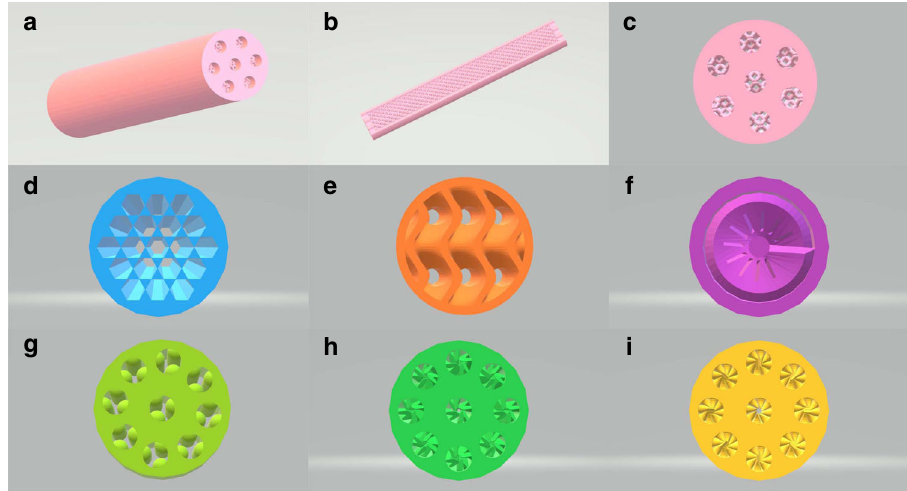
Fig. 3 Geometrical structures of Co-SCRs. ( a ) Co-SCR-1; ( b ) longitudinal section of Co-SCR-1; ( c ) cross-section of Co-SCR-1; ( d ) cross-section of Co-SCR-2; ( e ) cross-section of Co-SCR-3; ( f ) cross-section of Co-SCR-4; ( g ) cross-section of Co-SCR; ( h ) cross-section of Co-SCR-5; ( i ) cross-section